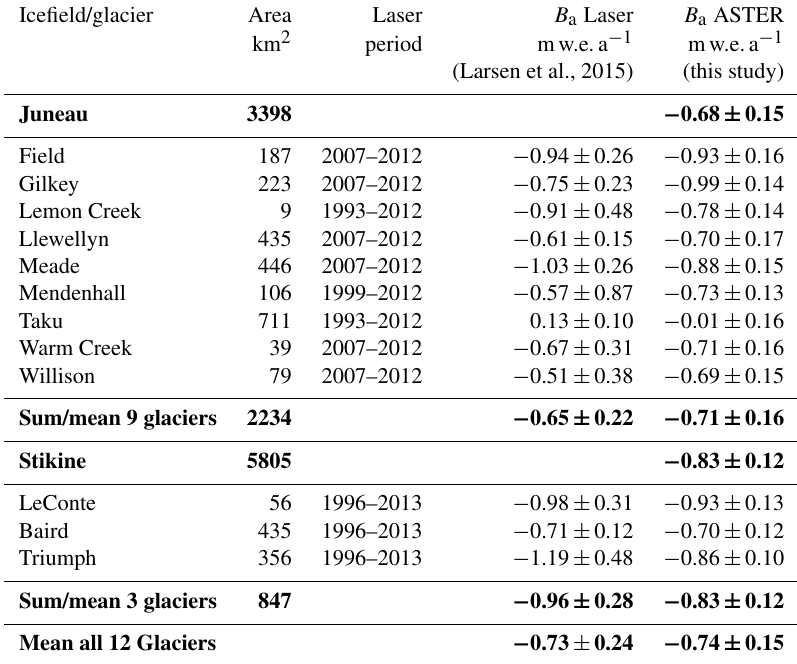
Table 1. Glacier-wide mass balances ( B a ) of 12 individual glaciers of the JIF and SIF derived from airborne laser altimetry for different periods (Larsen et al., 2015) and calculated in this study using ASTER DEMs from 2000 to 2016. Uncertainties for the mean mass balances of 9 (JIF), 3 (SIF) and 12 (JIF and SIF) glaciers are calculated as the area-weighed mean of uncertainties for individual glaciers. In bold, we highlight average mass balances for entire icefields or groups of